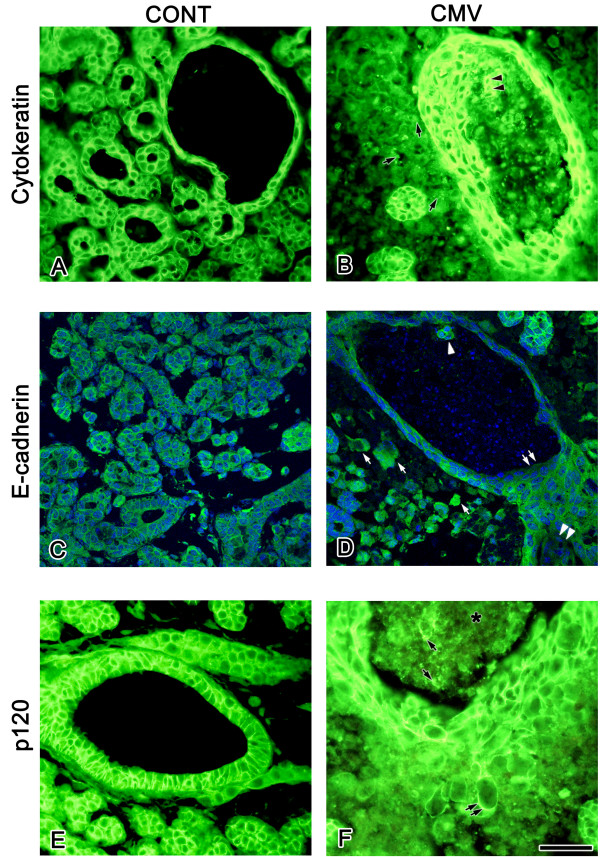
Cell characterization: cytokeratin, E-cadherin, p120. A, B. In control SMGs (A), cytokeratin is immunodetected in branching epithelia and not in mesenchyme; with mCMV infection (B), cytokeratin is detected in the abnormal epithelia, in lumen-filling cells (double black arrowheads), and in the cytoplasm of stromal cells (black arrows) adjacent to pseudostratified epithelia. C, D. In control SMGs (C), E-cadherin is localized solely to epithelial cell membranes. In mCMV infected SMGs (D), a decrease in E-cadherin immunostain is seen in epithelial cells facing the lumina (double white arrows) and in pseudostratified epithelia facing the stroma (double white arrowheads); E-cadherin is also localized to membranes of lumina-filling cells (white arrowhead) and to the cytoplasm of some metaplastic stromal cells (white arrow) adjacent to abnormal epithelia. E, F. p120 localization. In control SMGs (E), p120 is detected adjacent to epithelial plasma membranes and is absent from mesenchyme. With mCMV infection (F), p120 is seen in all epithelia, as well as in cells emigrating from ductal epithelia to stroma (double black arrow) and lumen-filling cells (black arrows). C, D were counterstained with DAPI. * lumen-filling cells. Bar: A, B, E, F: 20 μm; C, D: 27 μm.